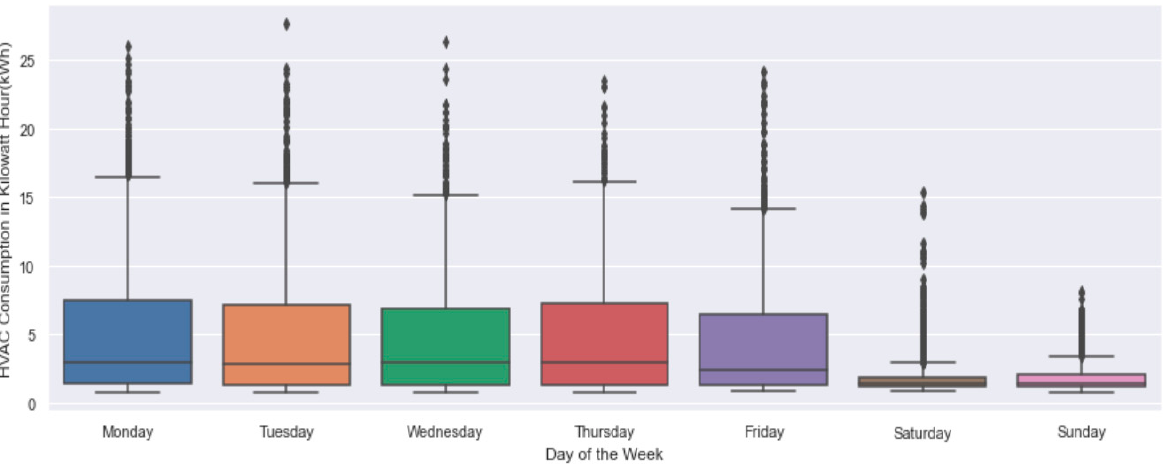
Figure 8. HVAC consumption per days of the week .